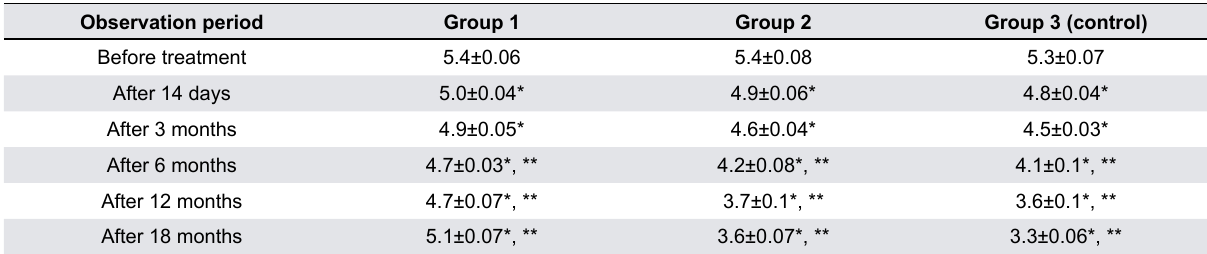
Table 3- The dynamics of the periodontal index change